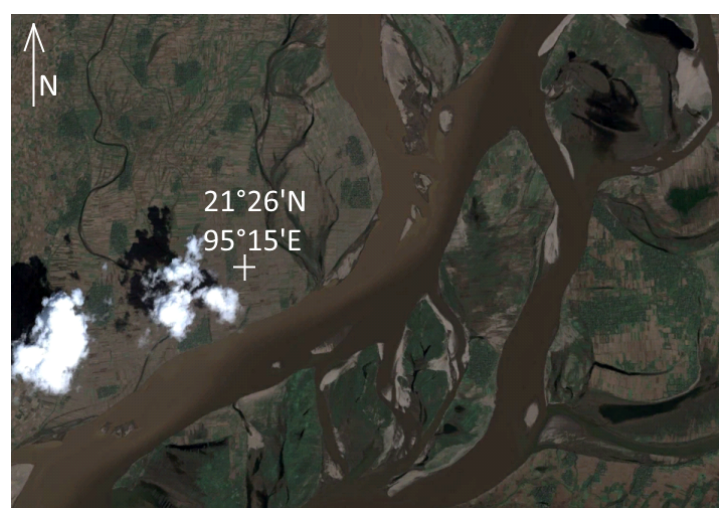
Figure 3. Aerial photograph of the Chindwin–Irrawaddy confluence on 26 October 2009. Flows are from top to bottom. Source: Google Earth (edited).